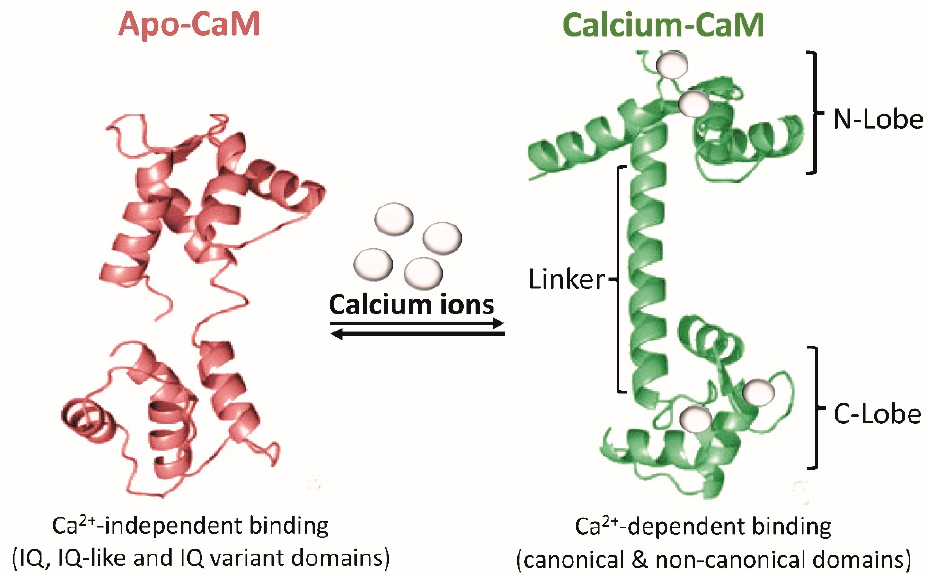
Figure 2. Conformational change in calmodulin (CaM) induced by calcium ions and its implications to target protein binding. These events are discussed, along with the various binding domains, in the main text.